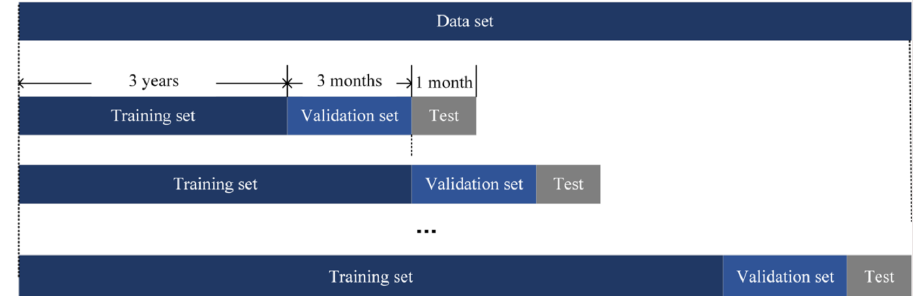
Figure 9. Time series dataset splitting